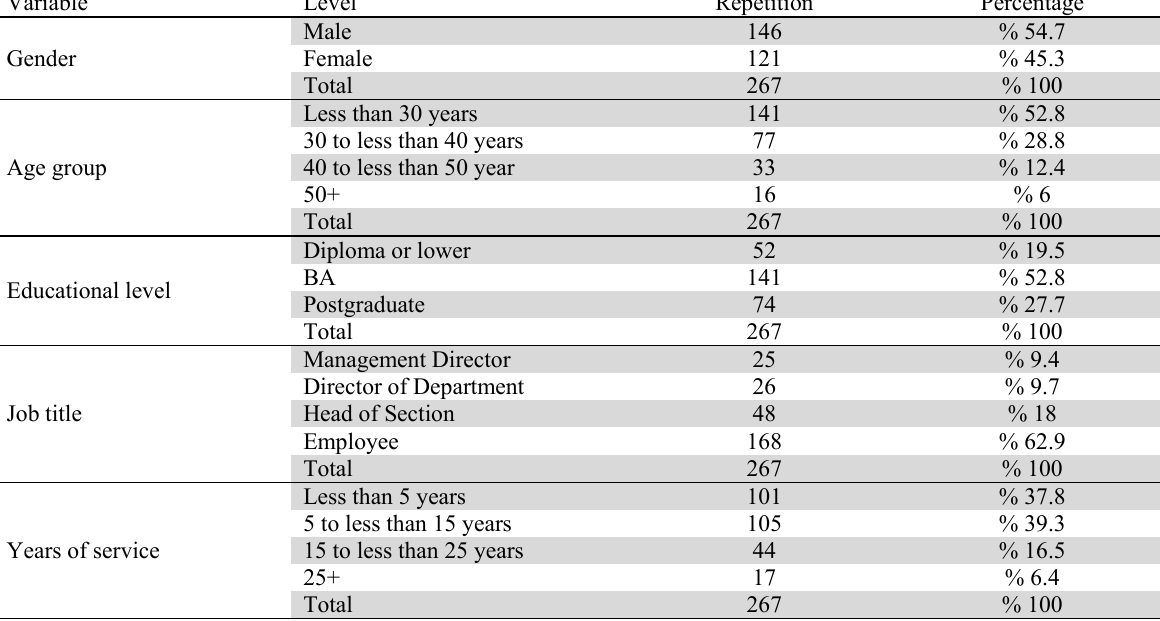
Distribution of Study Sample According to Demographic and Functional Data (N = 267) Variable Level Repetition Gender